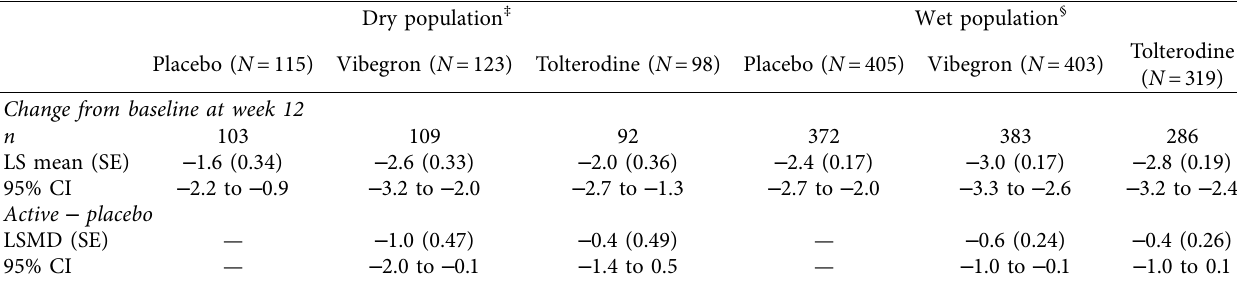
Table 2: Change from baseline at week 12 in mean daily number of urgency episodes † .